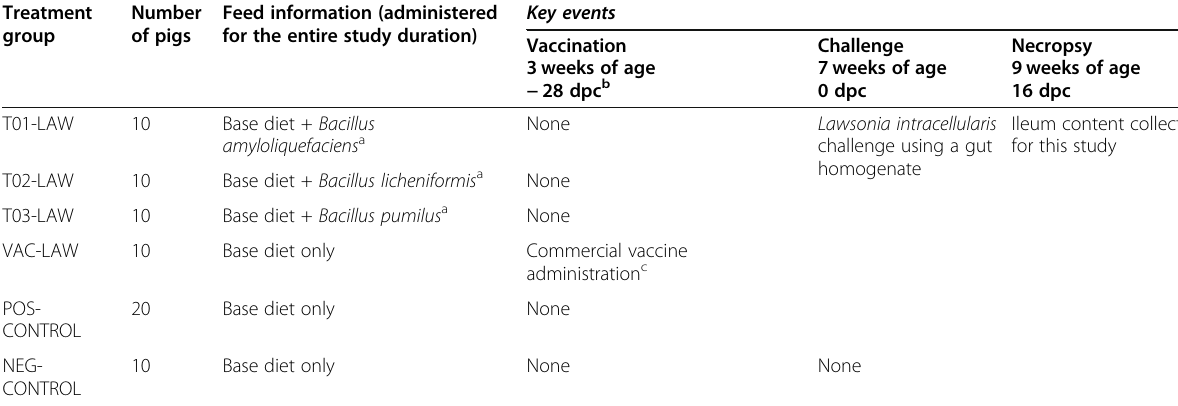
Table 1 Experimental design Treatment